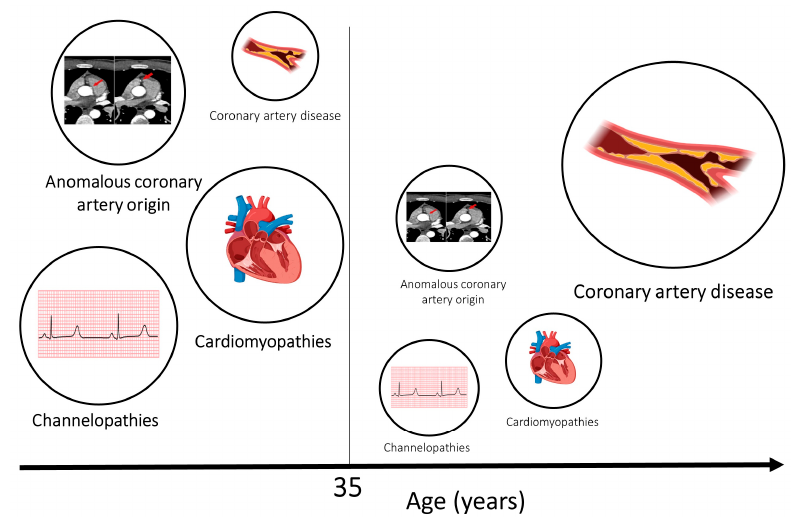
Figure 2. Aetiologies of SCD in athletes and age. Cardiomyopathies, channelopathies and congenital anomalies of the coronary arteries are prevalent causes in younger individuals. Atherosclerotic coronary artery disease is the most common cause of sudden cardiac death and sudden cardiac arrest in older individuals. The size of the circles relate to the relative frequency of SCD caused by the respective pathology. Age 35 has been used as a threshold as this is the most frequently used age in the literature; however, a clear line in terms of age is difficult to draw.